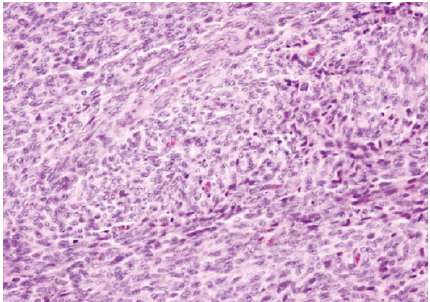
Figure 4: Hematoxylin and eosin stain of caecal endometrial stromal sarcoma, showing round to oval spindle-shaped nuclei with nuclear atypia.